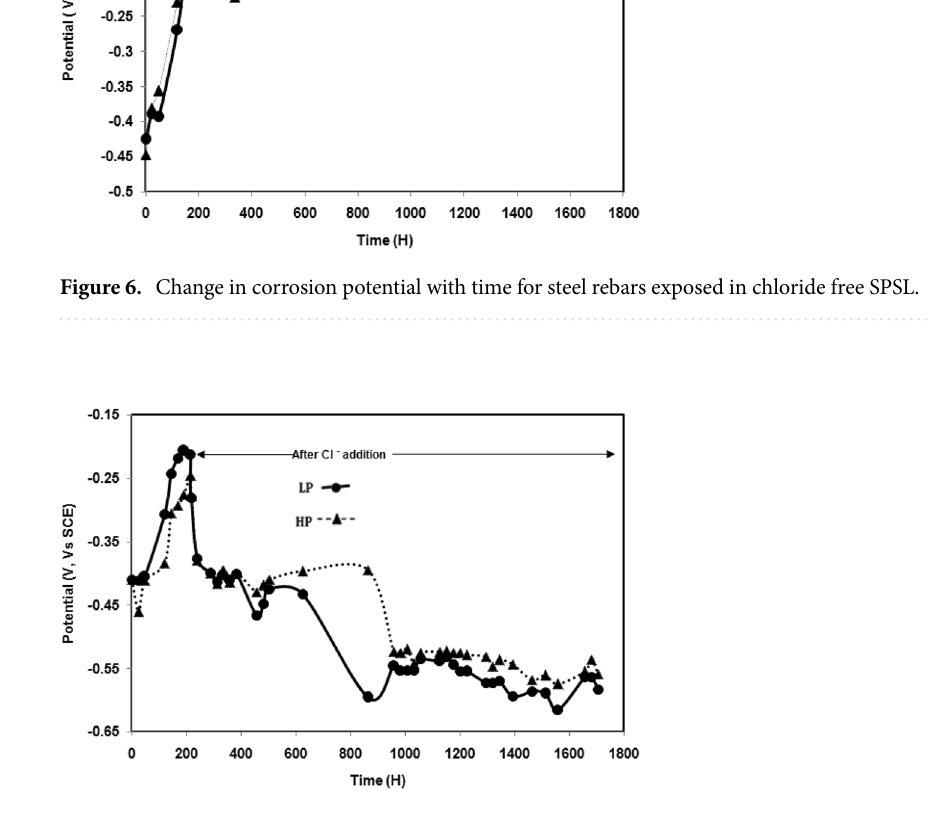
Figure 7. Change in corrosion potential with time for steel rebars exposed in chloride added